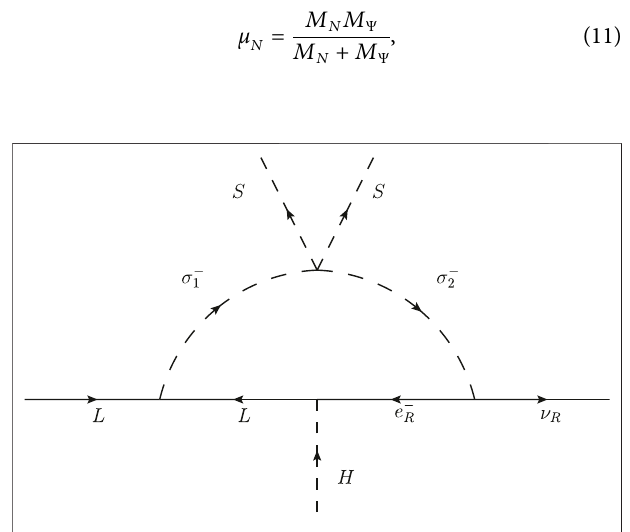
FIGURE 4 | Diagram with the X -charge fl ux of the fi elds in the one-loop Dirac Zee model which realizes the effective Dirac neutrino mass operator at d =